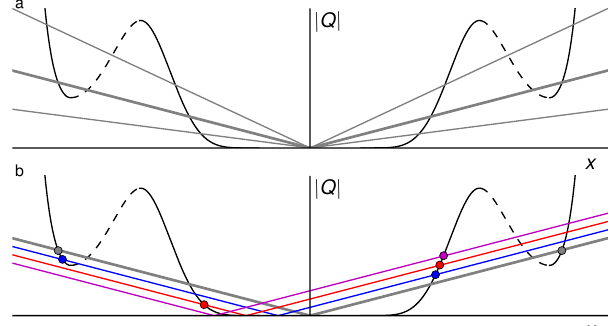
Figure 8. Conceptual picture to identify steady-state grounding line positions and analyze basin stability. The grounding-line flux Q g (black curve) according to Eq. (1) is shown for a symmetric, overdeepened bed shape used in our experiments. The dashed lines mark the sections of retrograde bed. (a) Different gray lines show the mass gain through snowfall, ax , for a symmetric ice sheet for three different magnitudes of surface accumulation a . Intersections of Q g and ax yield possible steady-state grounding line positions. (b) Colored lines give a(x − x i ) for one accumulation magnitude (thick line in panel a ) but different positions of the ice divide, x i , that is shifted leftward in response to an assumed destabilization of basin r. Grounding line positions (circles) are shown for the three scenarios S (blue), U (red) and C (purple) discussed in this study as well as an initial symmetric steady state